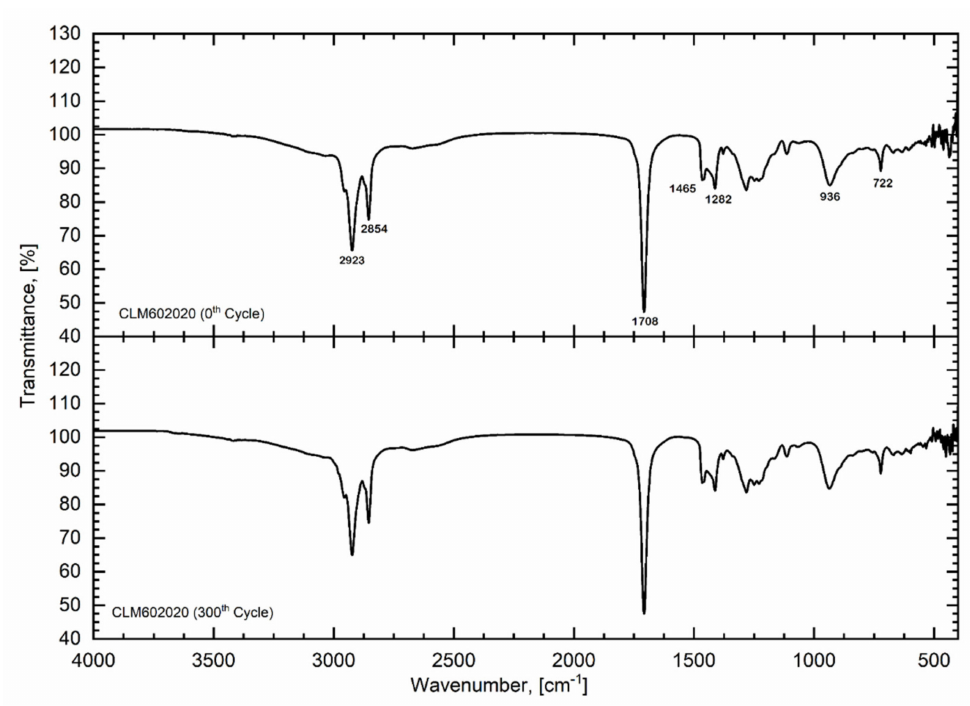
Figure 14. FTIR result at 0th and 300th